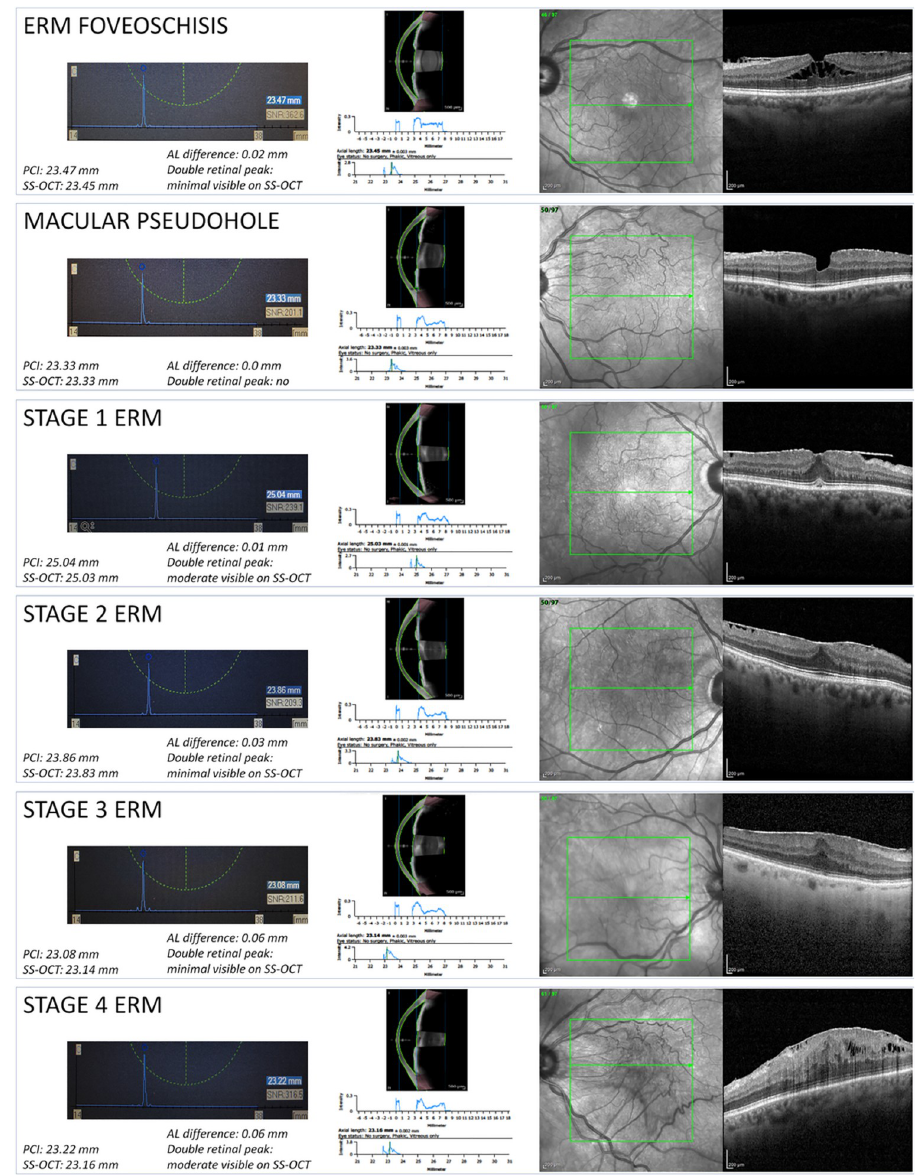
Fig 1. Subgroup biometric outputs and OCT scans. The six rectangular boxes represent the six subgroups analysed in the study, as reported in the captions (top left). Left part: in the light blue rectangles are reported the biometric outputs (x-y graphs) from the PCI device. The axial length (AL) in mm is reported on the x-axis, the signal amplitude is reported on the y-axis. The peak of the blue line is normally placed at the retinal pigment epithelium (RPE) level. The small blue rectangle on the right reports the mean AL. The small white rectangle on the right reports the signal-to- noise ratio (SNR). Middle part: anterior segment SS-OCT scan (top), graph reporting the signal intensity throughout the anterior segment (middle) and the biometric outputs (x-y graphs) from the SS-OCT device (bottom). In the biometric output the AL in mm is reported on the x-axis, the signal amplitude is reported on the y-axis. The blue line may present a single or double retinal peak. When present, the first retinal peak is located at the vitreoretinal interface, while the second peak is located at the RPE level. Right part: infrared image of the posterior pole (left) and horizontal OCT B scan (right) passing through the fovea. Left part, bottom: PCI and SS-OCT mean AL measurements. Left part, middle: AL differences between the devices and shape of the biometric outputs; when present, a double peak was described as minimal (intensity below < 50% of the second peak), moderate (between 50% and 100%), significant ( > 100%).